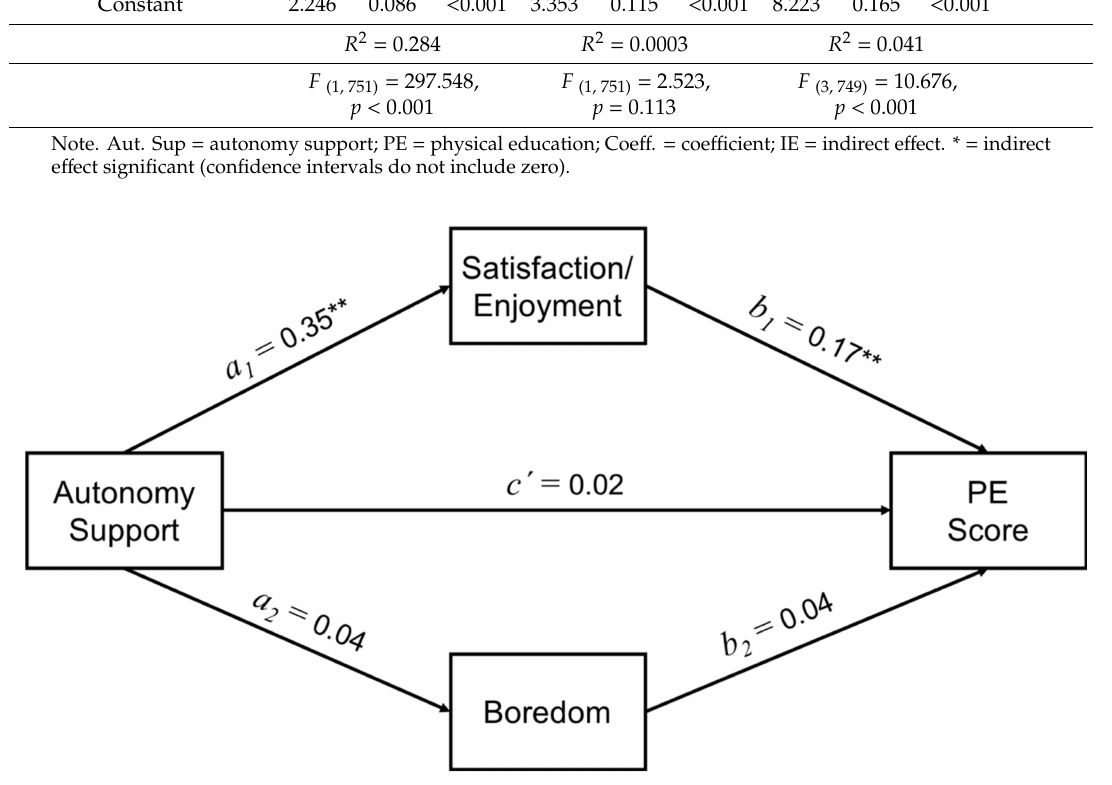
Figure 1. Statistical diagram of the satisfaction / enjoyment and boredom as mediators between autonomy support with PE score. ** p <